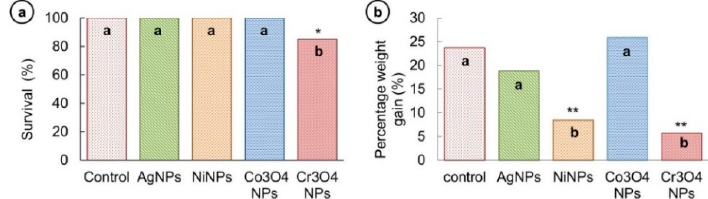
Figure 6. ( a ) Survival rate of fish in control, AgNP-, NiNP-, and Co 3 O 4 NP-exposed groups was 100%. The fish treated with Cr 3 O 4 NPs had a significantly low survival rate (86%). ( b ) Percentage weight gain was not significantly different among control, AgNP- and Co 3 O 4 NP-exposed fish while it was significantly lower in NiNP- and Cr 3 O 4 NP-exposed fish. Columns showing different letters ( a , b ) are significantly different, (* p < 0.05) (** p < 0.01).